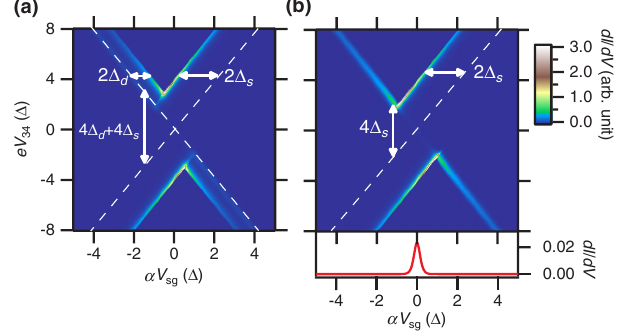
FIG. 3. Simulation of pair conductance diamonds on varying gapped excitations in the leads. (a) When both source and drain leads only have gapped excitations, the diamonds are offset away from the gapless excitations indicated by the dashed lines. An Δ =e appears between the tips of insulating gap of 4 ð Δ s þ d Þ diamonds, where Δ FIG. 4. Theoretical calculation of DOS spectra in a single-level and Δ are the pairing gaps of source and s d QD in the presence of (a) attractive ( U ¼ − 4 Δ ) and (b) repulsive drain leads. (b) When the drain lead has gapless excitations, one ( U ¼ 2 Δ ) electron-electron interaction. For the case (a) of strong side of the diamonds stays connected by a straight line. Note attractive interactions, the two-electron “ X ” -shaped resonances electron pairs can still tunnel through the device when are dominant, whereas for case (b) of strong repulsion, the j V 34 j < 2 Δ s =e , as shown in the conductance peak at zero-bias dominant subgap “ loop ” features are one-electron resonances in the bottom panel. α on the x -axes is the lever arm ratio with Andreev bound states. converting V to sg